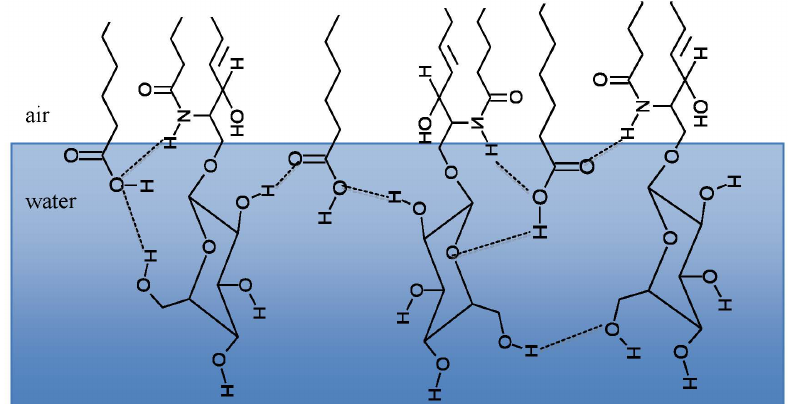
Figure 9. Possible hydrogen bonding network between PA and cerebroside headgroups. Hydrogen bonds are indicated by dashed